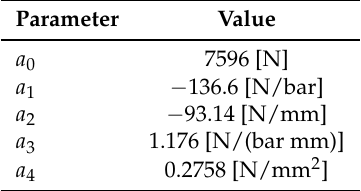
Table 1. Values of the parameters of the identified static force function.